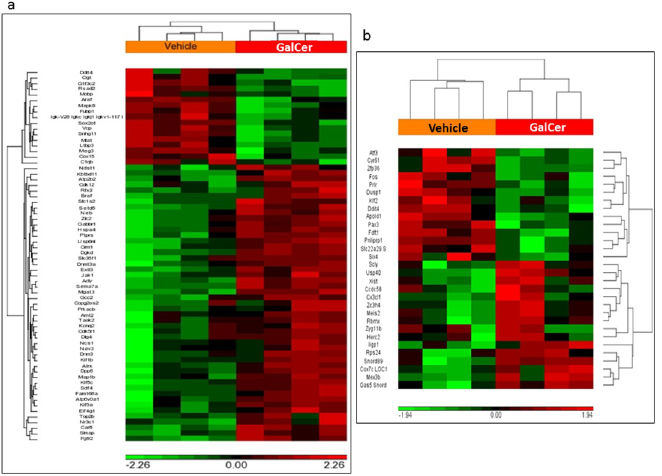
Fig 2. Differentially expressed genes in GalCer versus vehicle-treated male and female Cln3 Δ ex7/8 mouse brain. 2-dimentional heat maps of (a) 66 DEGs in male Cln3 Δ ex7/8 mice, and (b) 30 DEGs in female Cln3 Δ ex7/8 mice. Heat maps show mRNA abundance intensities of differentially expressed genes in profiled samples. Robust Multi-Array Average (RMA) preprocessed data is transformed to z-scores. The legend represents relative over- (red) and under- expression (green). Labeling at the top represents Vehicle control samples and GalCer-treated samples. A cut-off p- value < 0.05 and fold-change � ± 1.3 were assumed to identify genes significantly modulated by GalCer treatment.